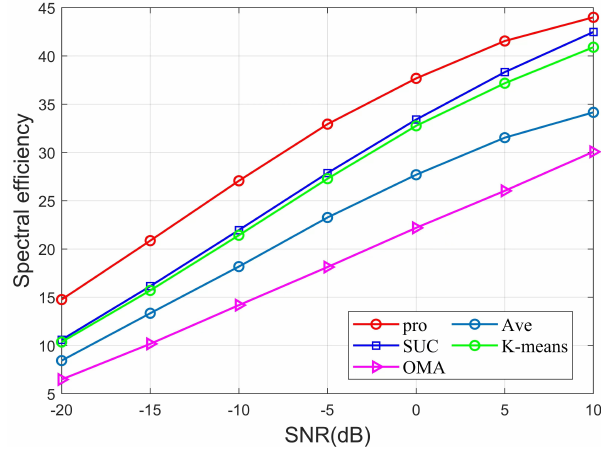
Figure 4. SE versus SNR of different algorithms.